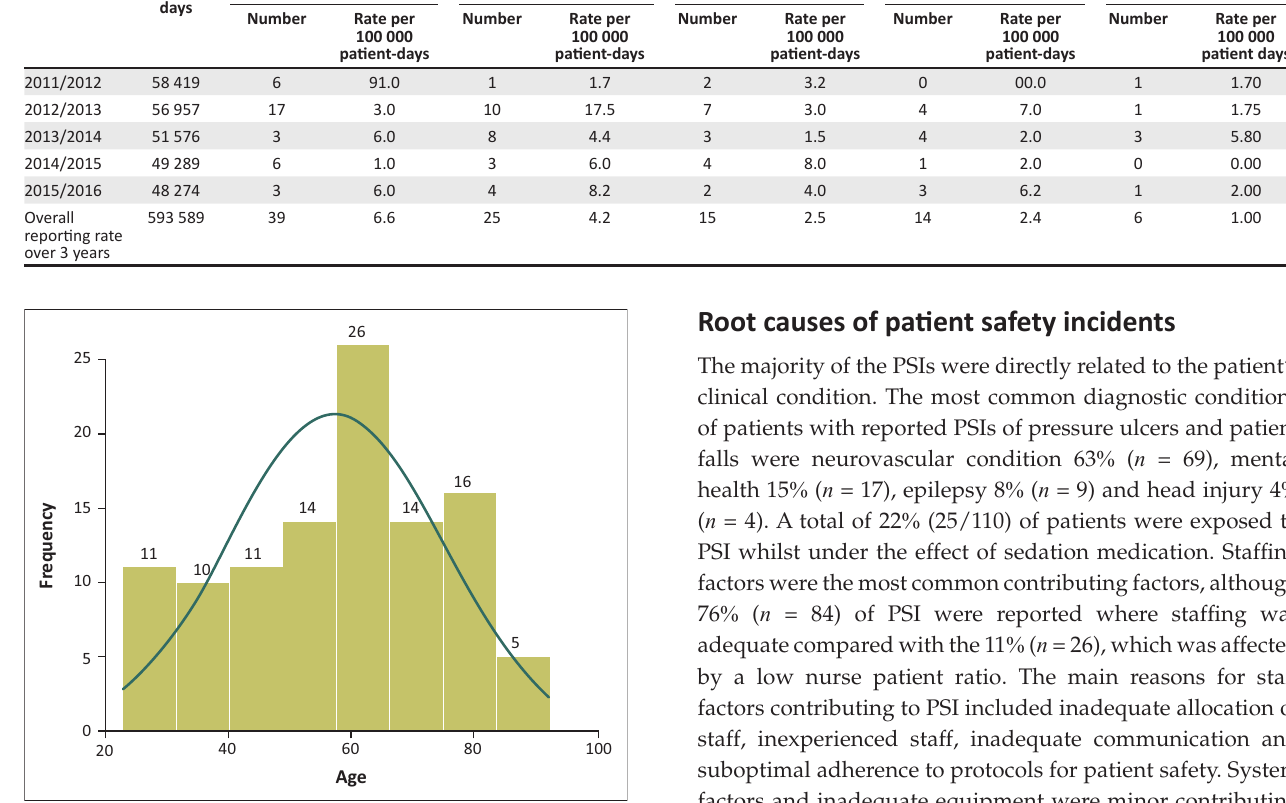
FIGURE 2: Age distribution of patients with adverse health events at Hillcrest hospital from April 2011 to March 2016.